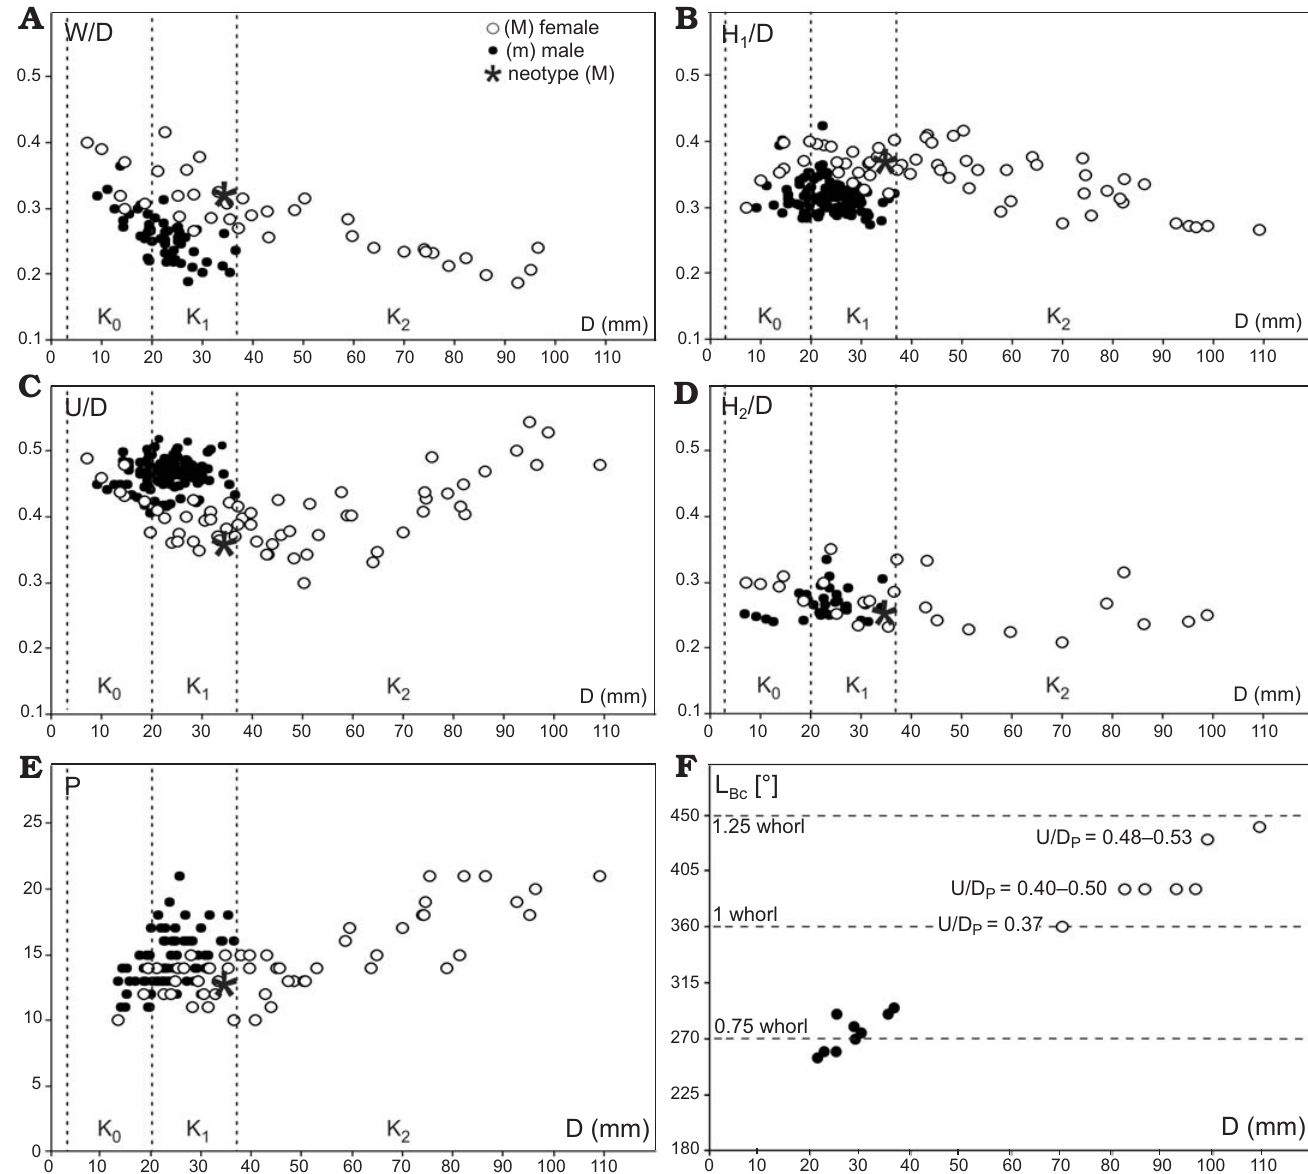
Fig. 4. Morphoceratid ammonite Polysphinctites tenuiplicatus (Brauns, 1865) [M and m], Lower Bathonian, Polysphinctites tenuiplicatus Zone, Polish Jura. Scatter plots of relative morphology of the studied sample: whorl width ratio ( A ), whorl height ratio ( B ), umbilical width ratio ( C ), ventral (or aper- tural) whorl height ratio ( D ), rib density ( E ), body chamber length of adults ( F ) versus diameter. The values of relative umbilical width at peristome indi- cated for macroconchs (U/D p ), covariating positively with L Bc and D p ; K 0 , K 1 , and K 2 , developmental stages (see Fig. 3B). Abbreviations: D, diameter; D p , diameter at adult peristome; H 1 /D, whorl height ratio; H 2 /D, ventral (or apertural) whorl height ratio; L Bc , length of the body chamber; P, number of primary ribs per half-whorl; U/D, umbilical width ratio; W/D, whorl width